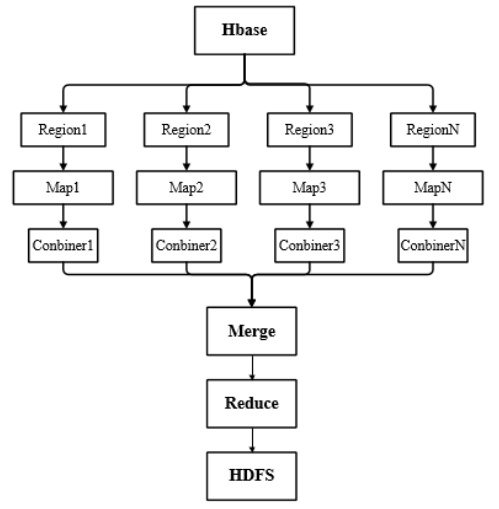
Figure 3. Image Retrieval based on Hadoop